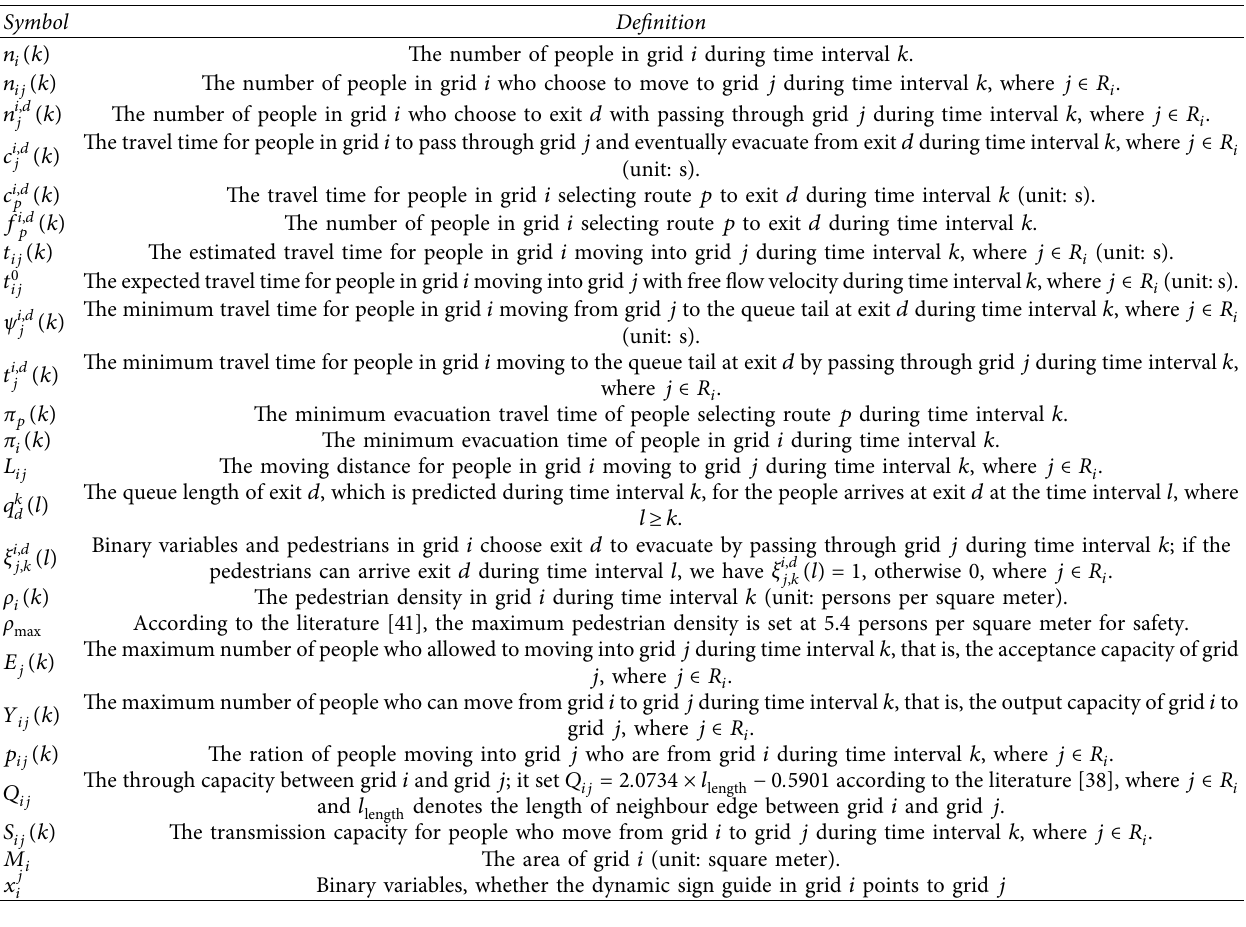
Table 1: : Temperature and wildlife count in the three areas covered by the study. Symbol Definition The number of people in grid i during time interval k